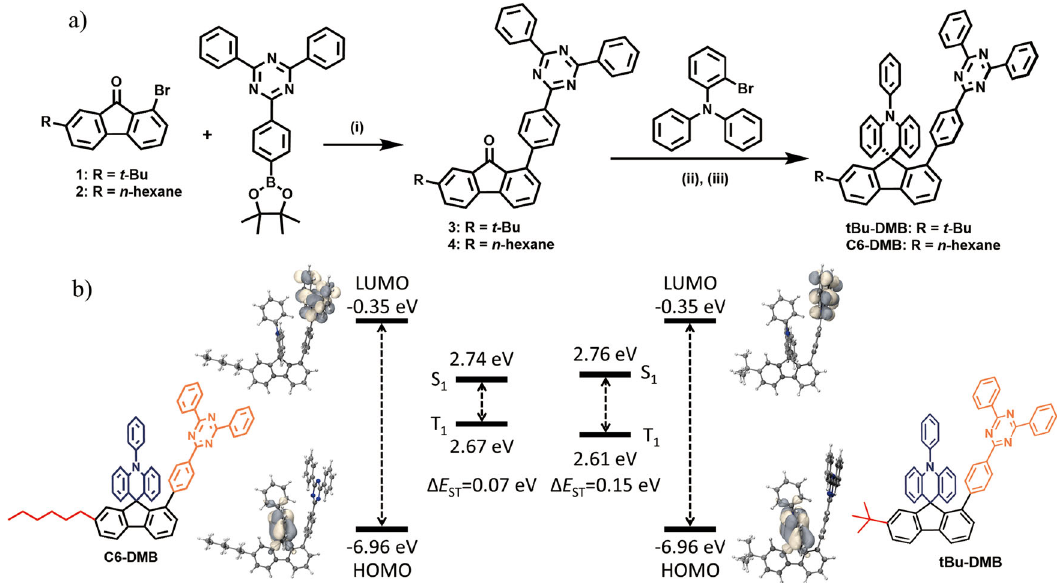
Fig. 2 Illustration of synthetic route and theoretical calculation result. a Synthetic route and b theoretical calculation of C6-DMB and tBu-DMB . Conditions: (i) Pd(PPh 3 ) 4 , K 2 CO 3 , toluene, ethanol, H 2 O, 105 °C; (ii) n -BuLi, THF, -78 °C; (iii) acetic acid, hydrochloric acid, 100 °C. Table 1. Summary of photophysical properties of C6-DMB and tBu-DMB .